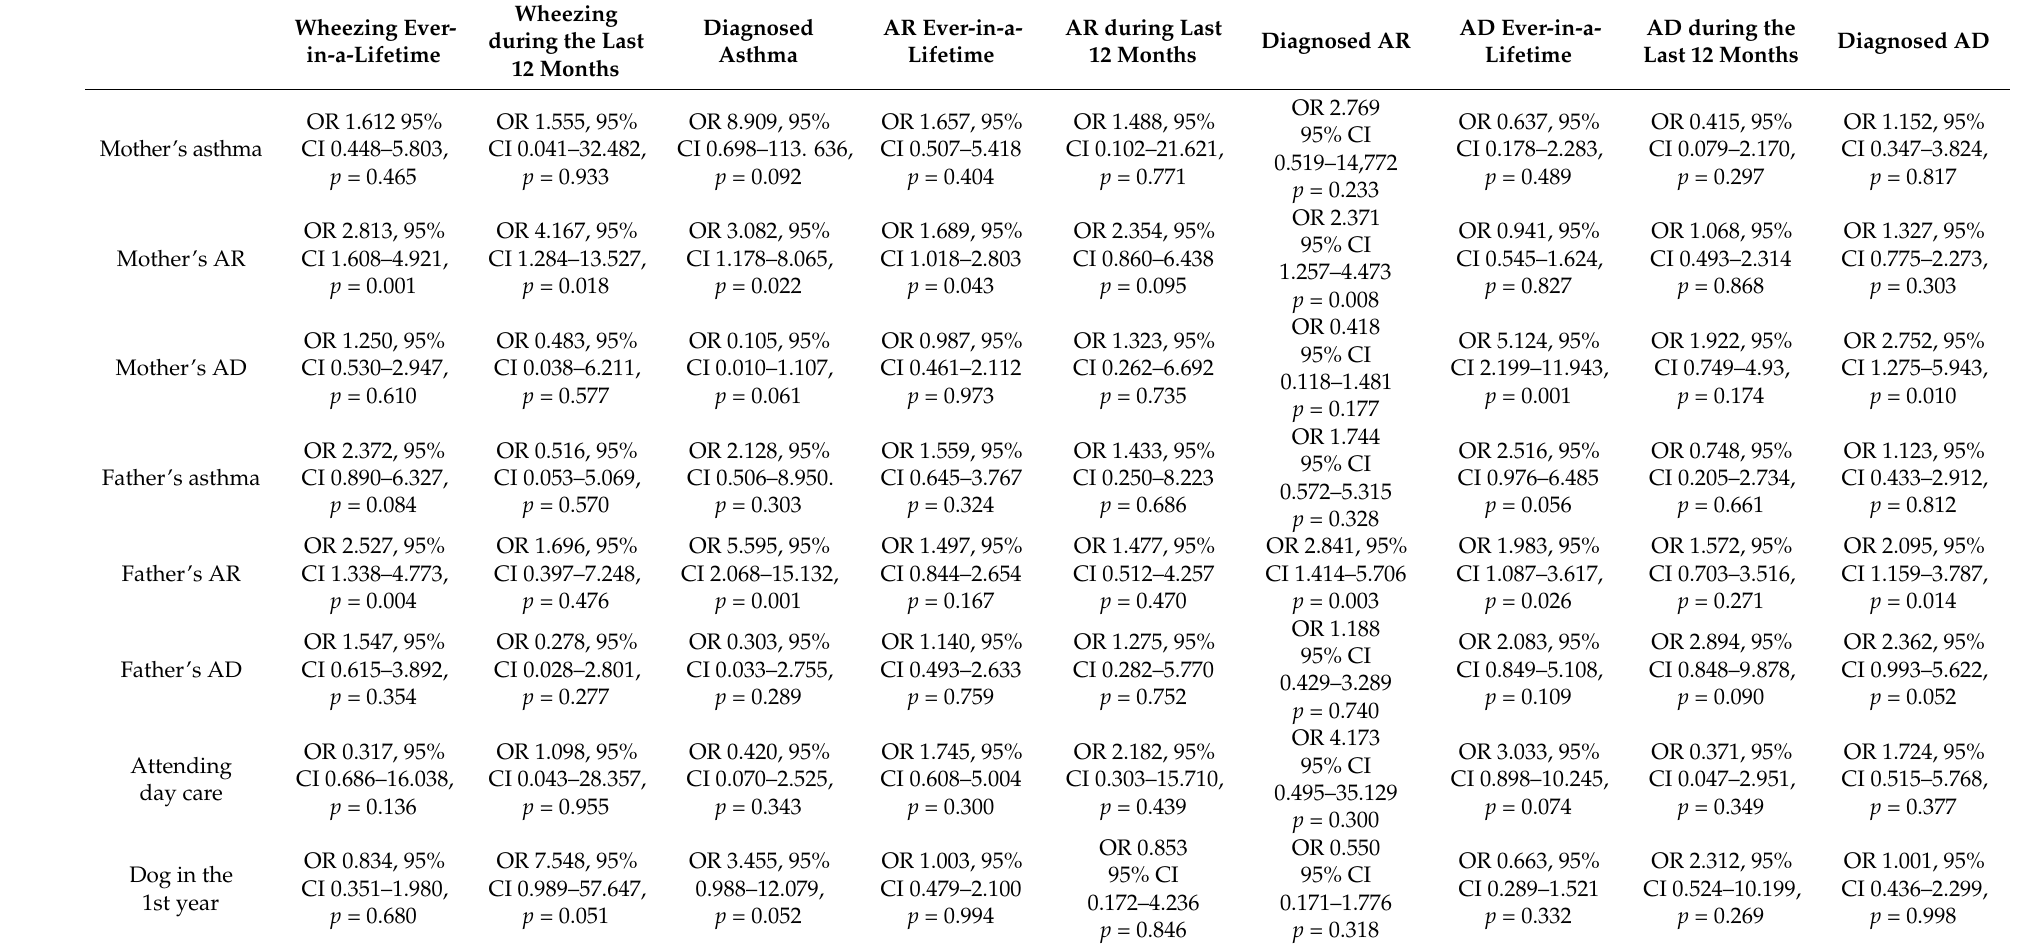
Table 3. Associations of family history and environmental factors with allergic